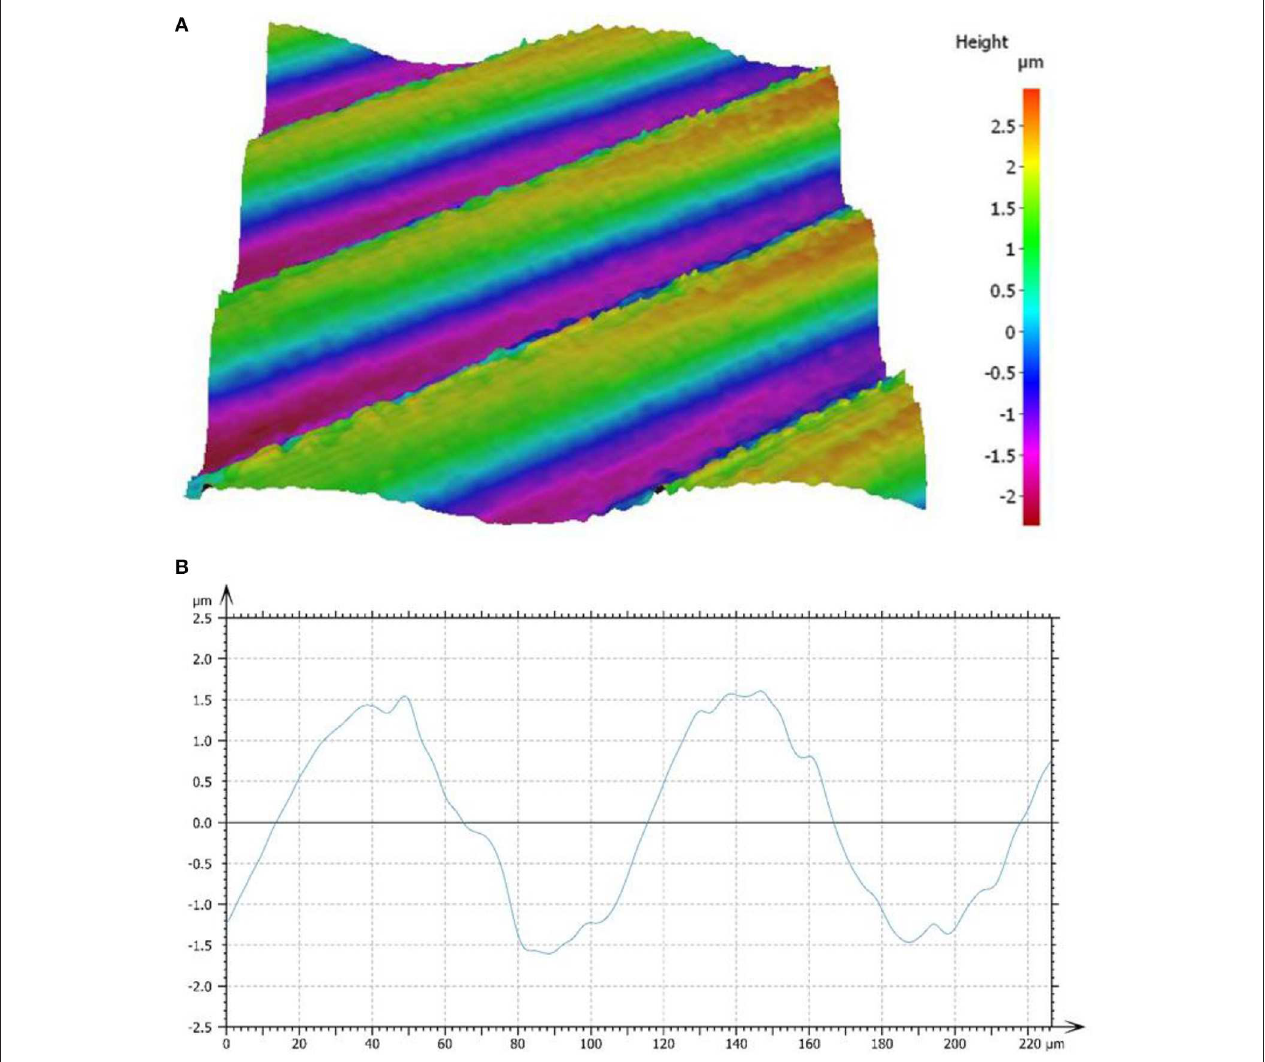
FIGURE 12 | The surface devoid of details obtained during polarized light measurement—the set polarization axis was 25 ◦ : (A) 3D surface view and (B) 2D profile.